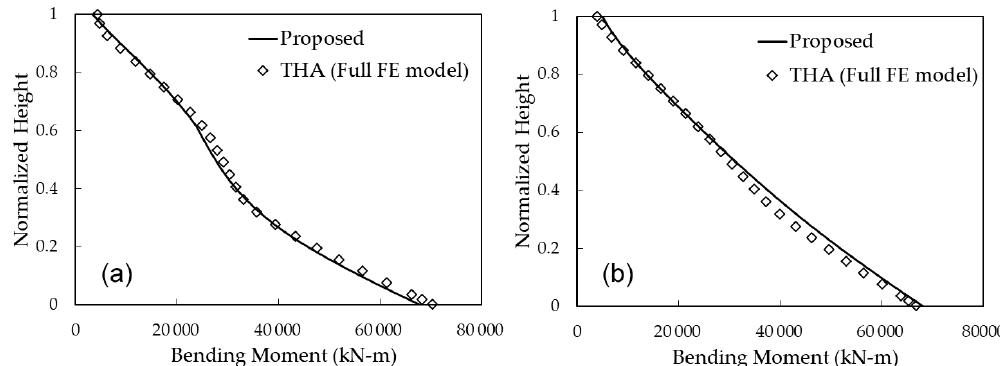
Figure 7. Vertical profiles of bending moments on the tower considering the additional loadings: (a) Soil type I and (b) Soil type II.